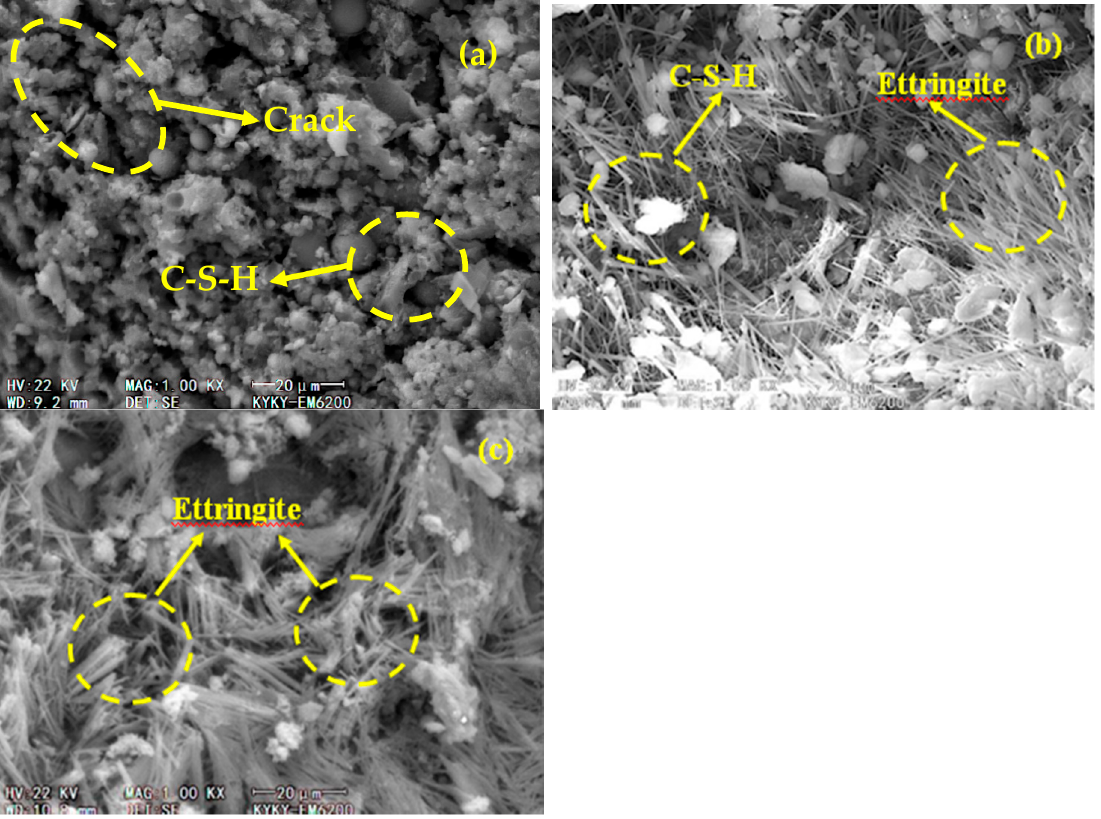
Figure 5. Microstructures of different concretes after 50 freezing and thawing cycles: ( a ) PC, ( b ) UM 10 , and ( c ) UM 21.